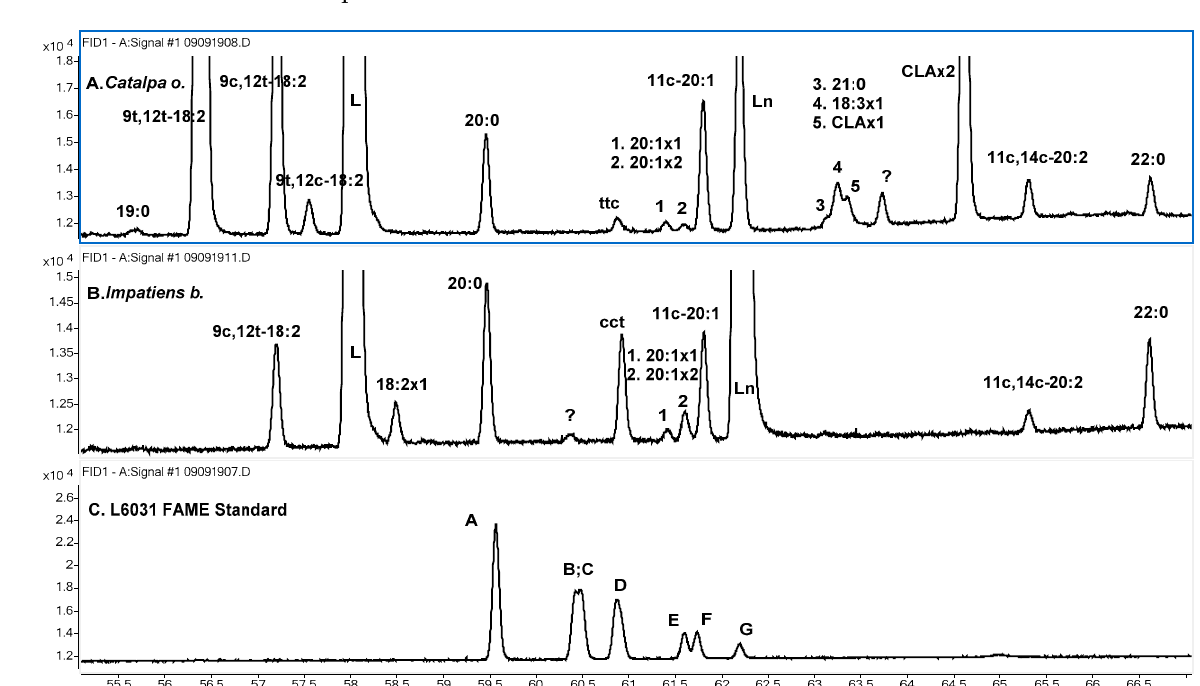
Figure 3. Chromatograms showing the 18:2 and non-conjugated 18:3 isomers on the SP-2560 column. ( A ) FID of Catalpa o. ( B ) FID of Impatiens b. ( C ) FID of L6031 standard containing the eight geometric 9,12,15-18:3 isomers. The configuration of the L6031 peaks is A ttt ; B ctt ; C tct ; D ttc and cct ; E ctc ; F tcc ; G ccc . Peaks marked ‘ ?’ in 3A and3 are unknowns for which MS evidence is not sufficient to support identification.